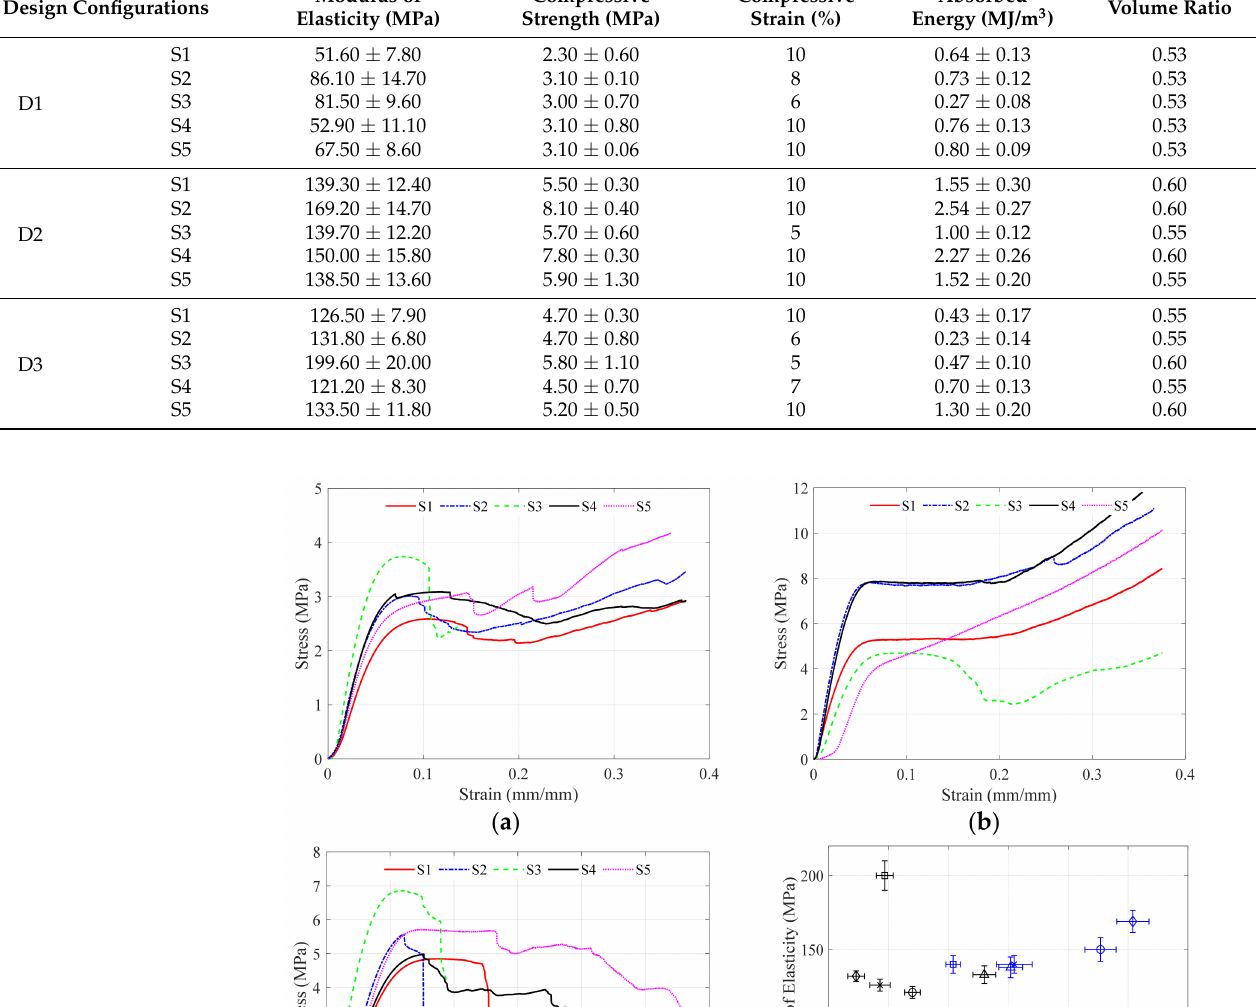
Table 2. The results for the average mechanical properties of dual graded lattice structure designs. Design Configurations